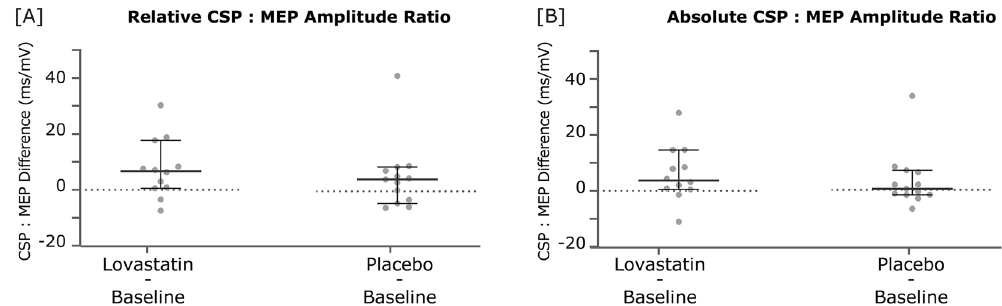
Figure 1. Differences in relative ( A ) and absolute ( B ) cortical silent period ratios, comparing measures taken after lovastatin and placebo intake with the baseline assessment. Dots represent, for each participant, the difference between lovastatin and baseline or placebo and baseline CSP:MEP ratios. Lines represent median and 95% CI. CSP cortical silent period, MEP motor-evoked potential, ms millisecond, mV millivolt, CI confidence